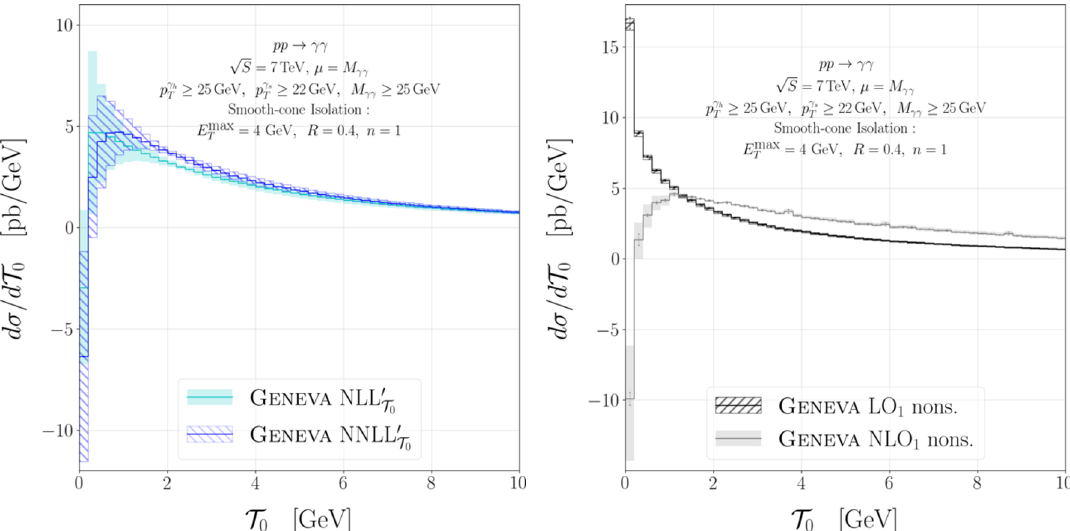
Figure 3 . Comparison between the NLL 0 and NNLL 0 resummed T 0 distributions in the peak region (left) and the corresponding nonsingular contribution (right).